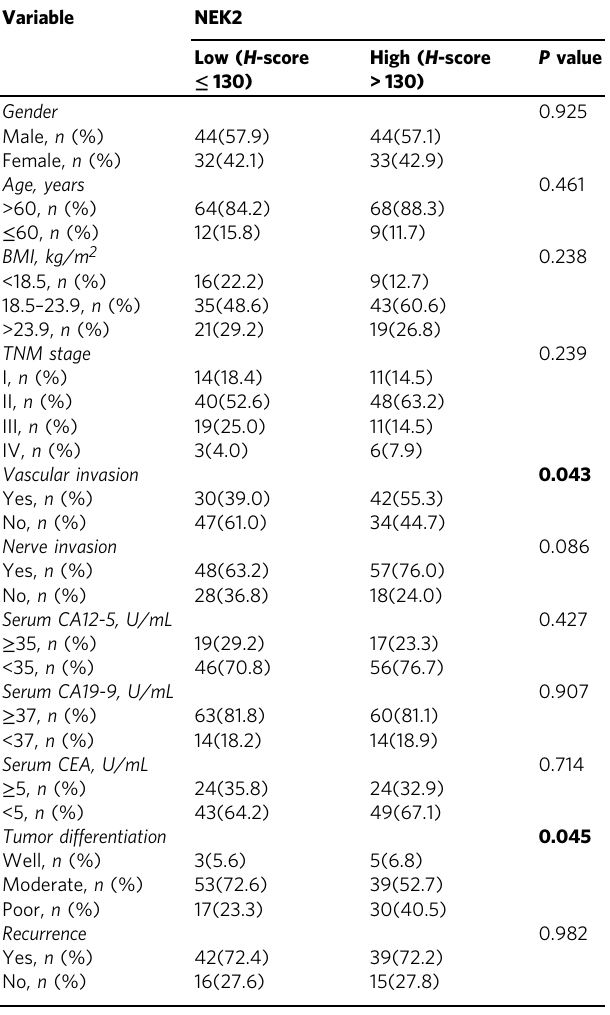
One-way and repeated-measures analysis of variance (ANOVA) was performed in Table 1. The bold values indicate p <